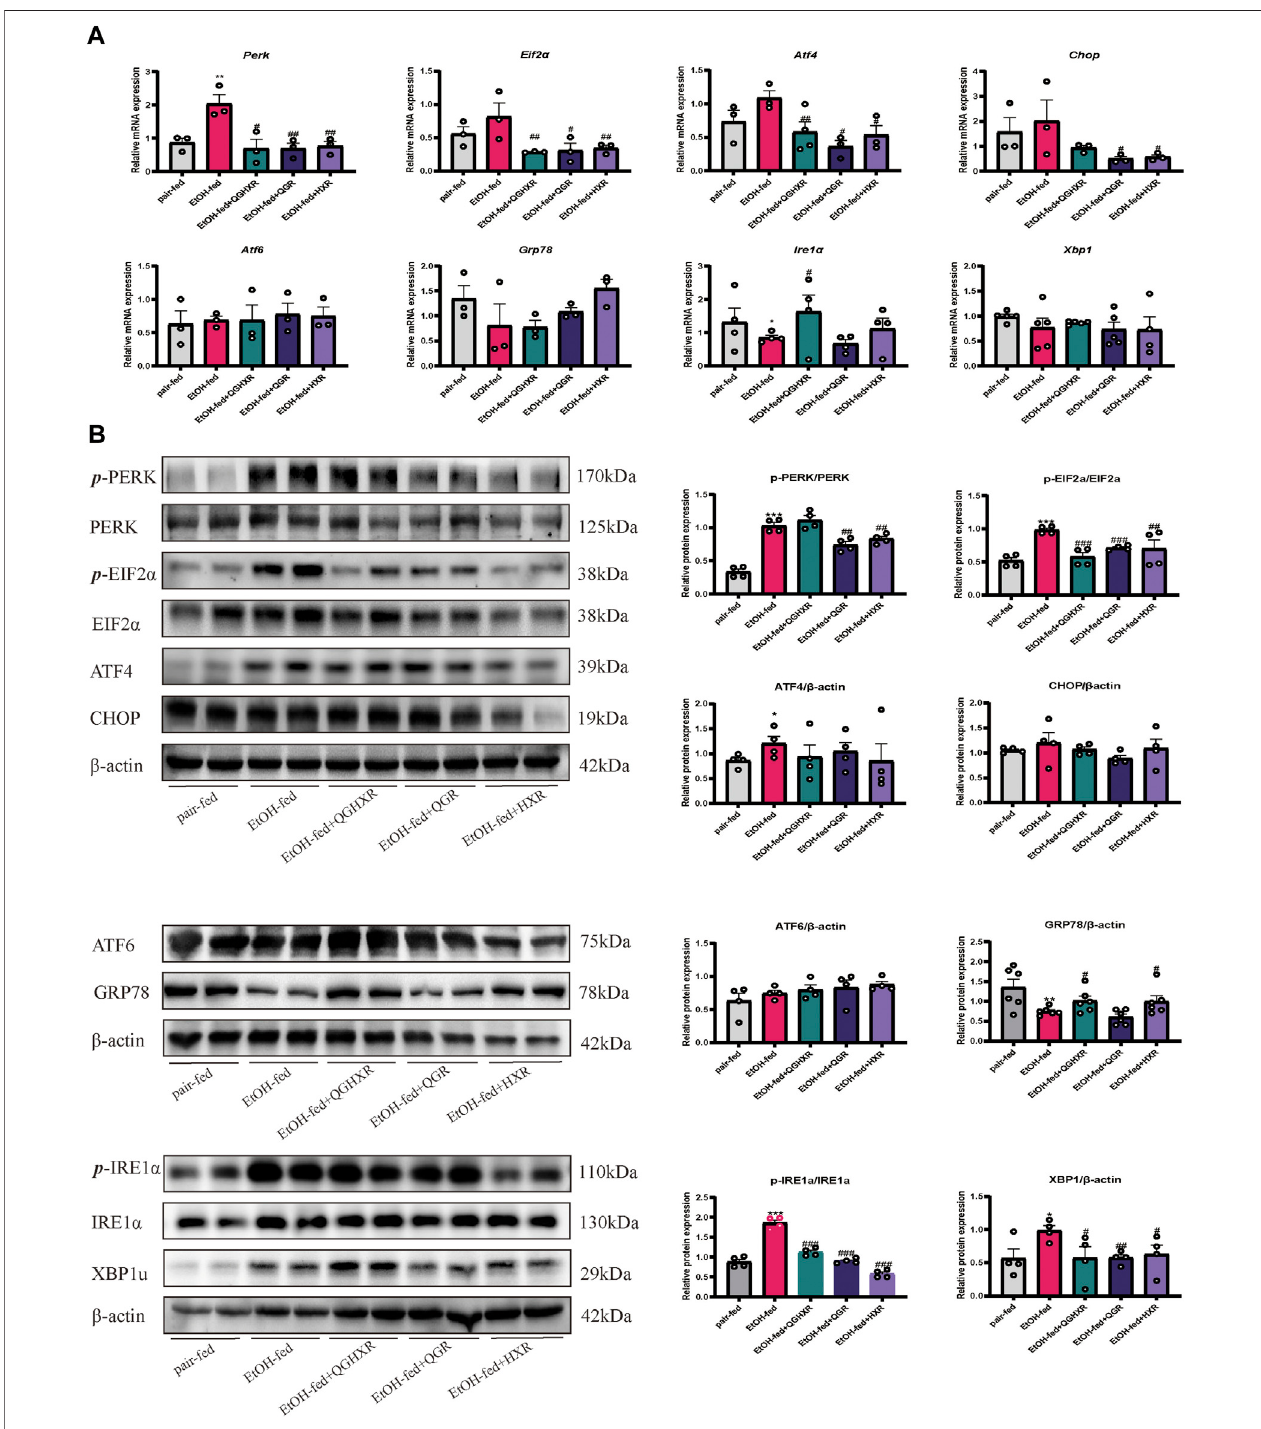
FIGURE2| ProtectiveeffectofQGHXRagainstalcohol-inducedliverinjuryinC57BL/6miceinvolvedmodulationoffactorsrelatedtoERS. (A) mRNAexpressionin liver samples; (B) protein expression in liver samples. The pair-fed group; EtOH-fed: ethanol-fed group; EtOH-fed + QGHXR: Qinggan Huoxue Recipe group with ethanol-fed;EtOH-fed +QGR:QingganRecipegroup withethanol-fed;EtOH-fed +HXR: HuoxueRecipe groupwithethanol-fed. For (A,B) ,quanti fi cation ofmRNAand protein level expression was normalized to β -actin levels, except protein phosphorylation level expression of PERK, eIF2 α , and IRE1 α was normalized to their prototypes. Data were presented as means ± SEM. Compared with the pair-fed group, * p < 0.05, ** p < 0.01, *** p < 0.001; Compared with the EtOH-fed group, # p < 0.05, ## p < 0.01, ### p < 0.001.